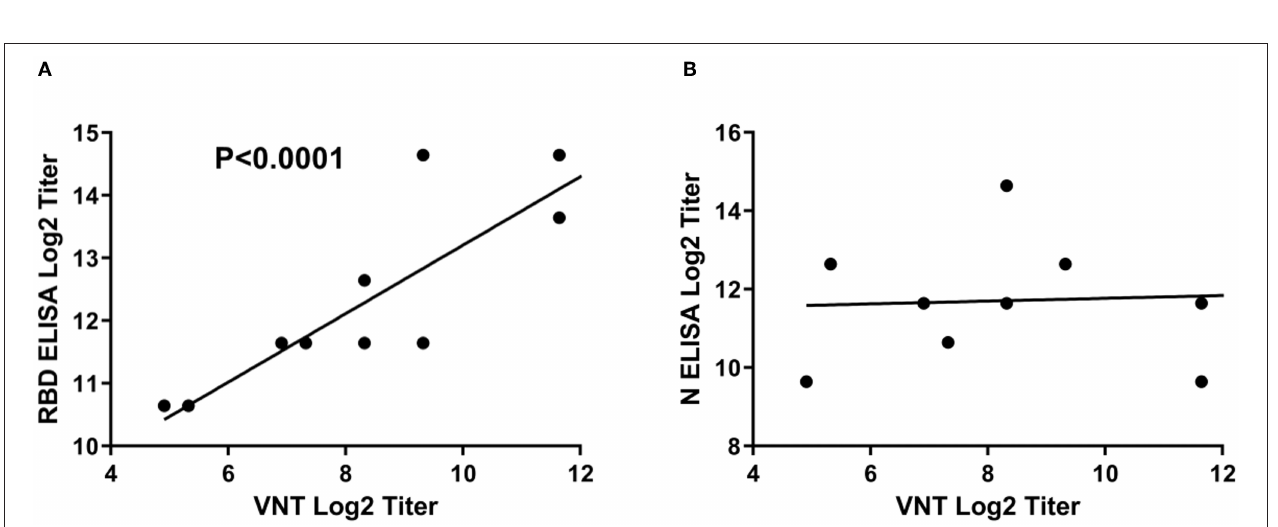
FIGURE 4 | Correlation of SARS-CoV-2 iELISA antibody titers with virus-neutralizing antibody titers. Linear regression analysis of RBD (A) and N (B) iELISA antibody titers in relation to virus-neutralizing antibody titers using SARS-CoV-2-positive cat sera was performed using GraphPad Prism software; RBD r 2 = 0.7924 and N r 2 =